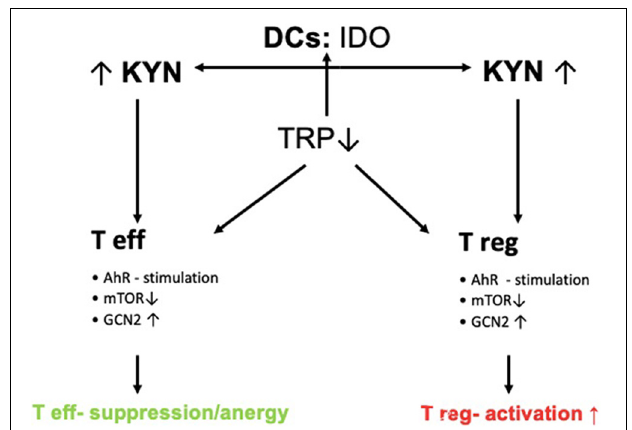
FIGURE 2 | Control of T-cell response by IDO. DCs express IDO thereby leading to increased Kyn-metabolite production. Increased Kyn-metabolites stimulate AhR and GCN2 and inhibit mTOR thereby leading to the activation of Tregs and inducing tolerance via suppression of effector T-cells (Teffs).